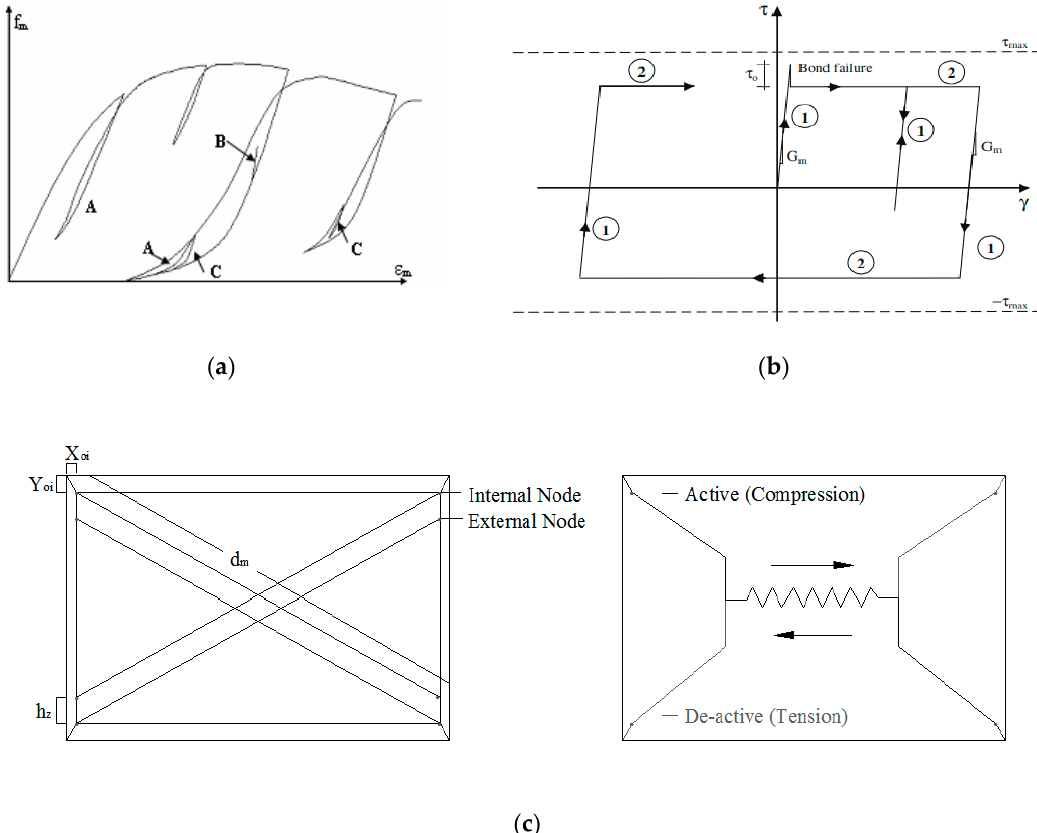
Figure 6. ( a ) Masonry strut hysteresis; ( b ) shear cyclic relationship; and ( c ) infill panel element configuration [36]. In this study, the distributed inelasticity is used to define the nonlinearity of structural members in the SeismoStruct program [30]. This distributed inelasticity is provided to the structural members as follows: the member was divided into three sections (top, bottom, and middle) and each section disintegrated into 150 fibers. Therefore, this method gives more accurate nonlinear behavior as compared to concentrated inelasticity. The dimension and reinforcement of the structural members are as per the IS 1893 (Part-1): 2016 and IS 13920: 2016 code [38]. The structural members detailing is shown in Figure 7 and the dimensions of structural members are presented in Table 3.